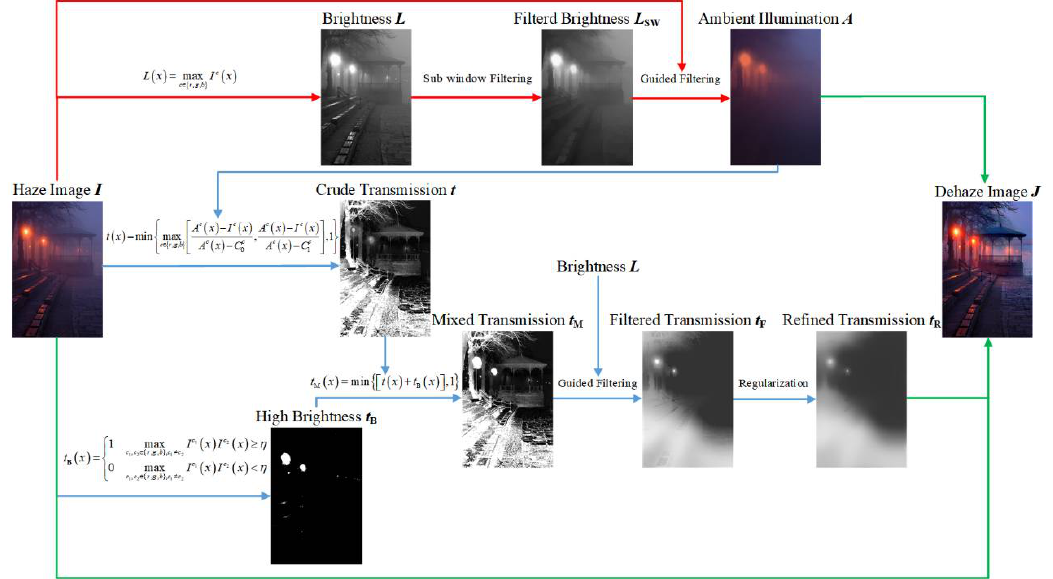
Figure 1. Flow chart of the proposed dehazing method. In this chart, the red line is the ambient illumination estimation method, the blue line is the transmission estimation method, and the green line is the result.